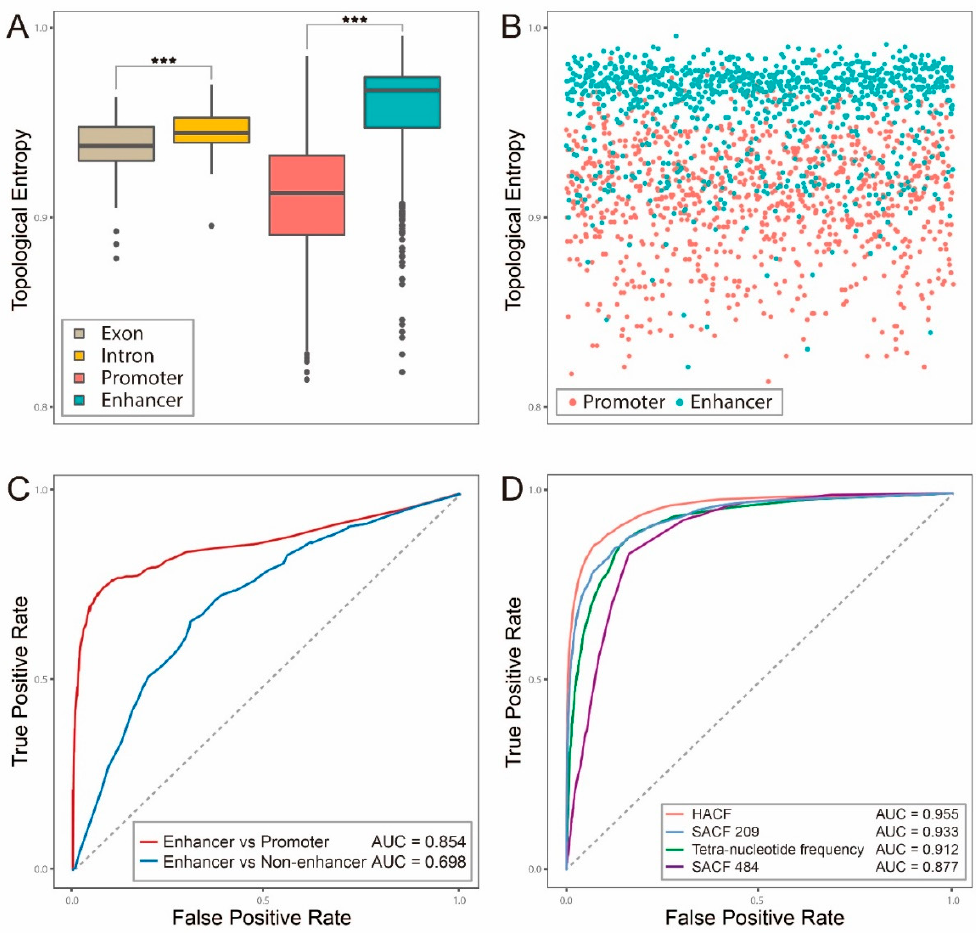
Figure 1. Topological entropies (TEs) of four distinct genomic elements and discriminating enhancer from promoter or non-enhancer with TE. ( A ).Box-plots of TEs of four distinct genomic elements including intron, exon, promoter and enhancer; *** represents p -value < 0.001; ( B )The point-plot of TEs of 200 longest promoters (red) against 200 longest enhancers (green); ( C ) Two ROC curves of prediction performances of two models with TE: enhancer versus promoter (red) and enhancer versus non-enhancer (blue); The p-value of T test between the AUC of two groups is 1.4 × 10 − 7 ; ( D ) ROC curves of prediction performances of four feature inputs on the dataset Enhancer4589. HACF: hybrid abelian complexity features; SACF484: the 484 selected abelian complexity features determined by an upper bound estimation; SACF209: the 209 selected abelian complexity features determined by Wilcoxon-test; The p-value of T test between AUC of HACF and SACF209 is 8.1 × 10 − 3 ; the p-value of T test between AUC of SACF209 and tetra-nucleotide frequency is 2.5 × 10 − 3 ; the p-value of T test between AUC of tetra-nucleotide frequency and SACF484 is 4.9 × 10 − 5 .